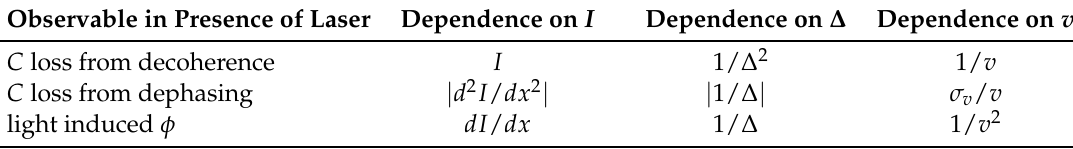
Table 1. Dependence on I , ∆ , and v for decoherence, dephasing, and phase shifts. Observable in Presence of